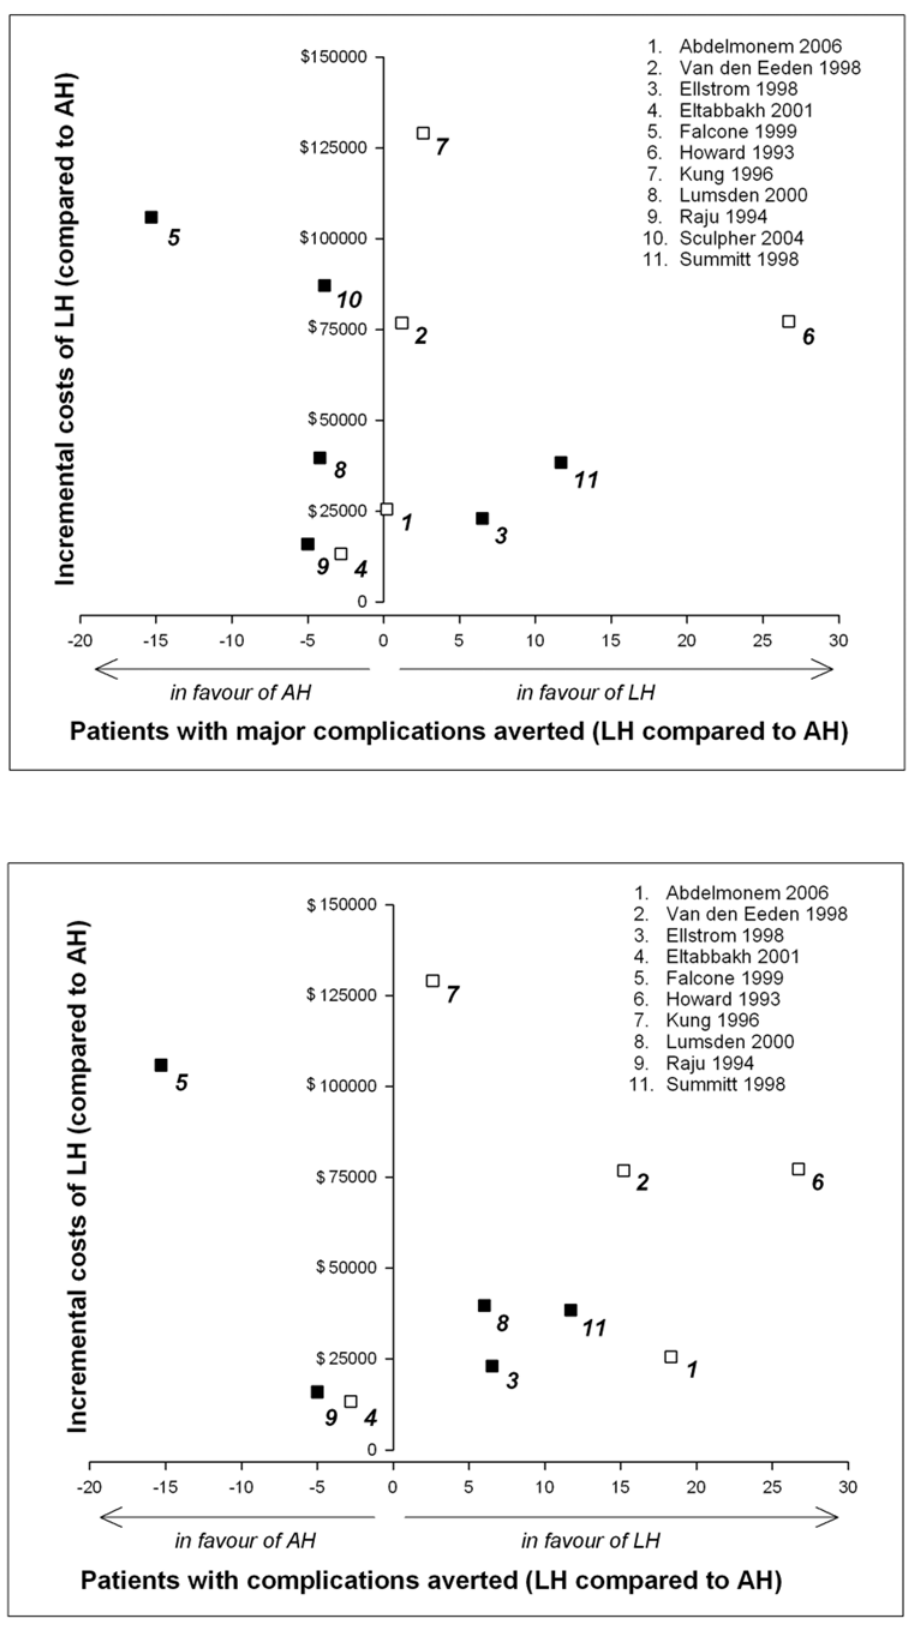
Figure 2. Incremental costs and effects for patients with major complications (A) and all complications(B) per 100 patients & = RCT % = CCT.